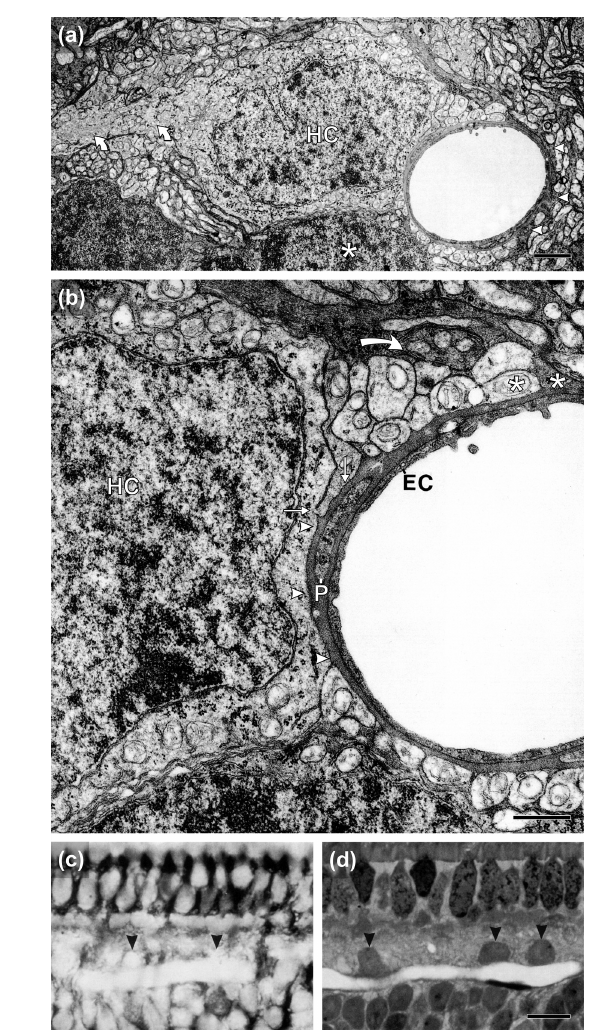
Figure 4. Horizontal cells ensheath capillaries in retinal capillary layer 1, adult Tupaia belangeri . (a, b) Transmission electron mi- crographs. (a) A horizontal cell (HC) invests the basal lamina of the capillary that, on the opposite side, is ensheathed by electron- dense processes of Müller cells (white arrowheads). Curved arrows, horizontal cell dendrite; asterisk, bipolar cell nucleus. (b) Detailed view of (a) . The electron-lucent perikaryon of the horizontal cell contacts the capillary basal lamina (arrowheads). Electron-lucent processes of the horizontal cell (continuity with the perikaryon in- dicated by small arrows) are enclosed by the electron-dense pro- cesses of Müller cells (curved arrow; asterisks: alternating con- tacts of electron-dense and electron-lucent processes at the capillary basal lamina). EC, endothelial cell; P, process of a pericyte. (c) The S-100-immunopositive glial ensheathment of the capillary is inter- rupted by horizontal cell perikarya (arrowheads). For a compari- son, see (d) : section thickness 1µm, hematoxylin. Scale bars = 1µm in (a) ; 0.5µm in (b) ; 10µm in (c, d) . Reproduced from Knabe and Ochs (1999, Figs. 1, 6a, b). © Springer-Verlag 1999, with kind per- mission from Springer Science and Business